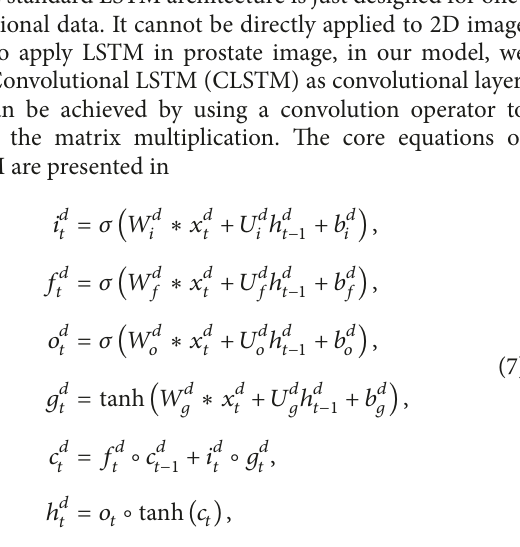
layer which consists of a sigmoid function. When getting the data from previous stage ℎ 𝑡−1 and input data 𝑥 𝑡 , the sigmoid function outputs a number 0 or 1 for each data in the cell state 𝐶 𝑡−1 , the number 0 represents completely throwing it away, while 1 represents storing it.